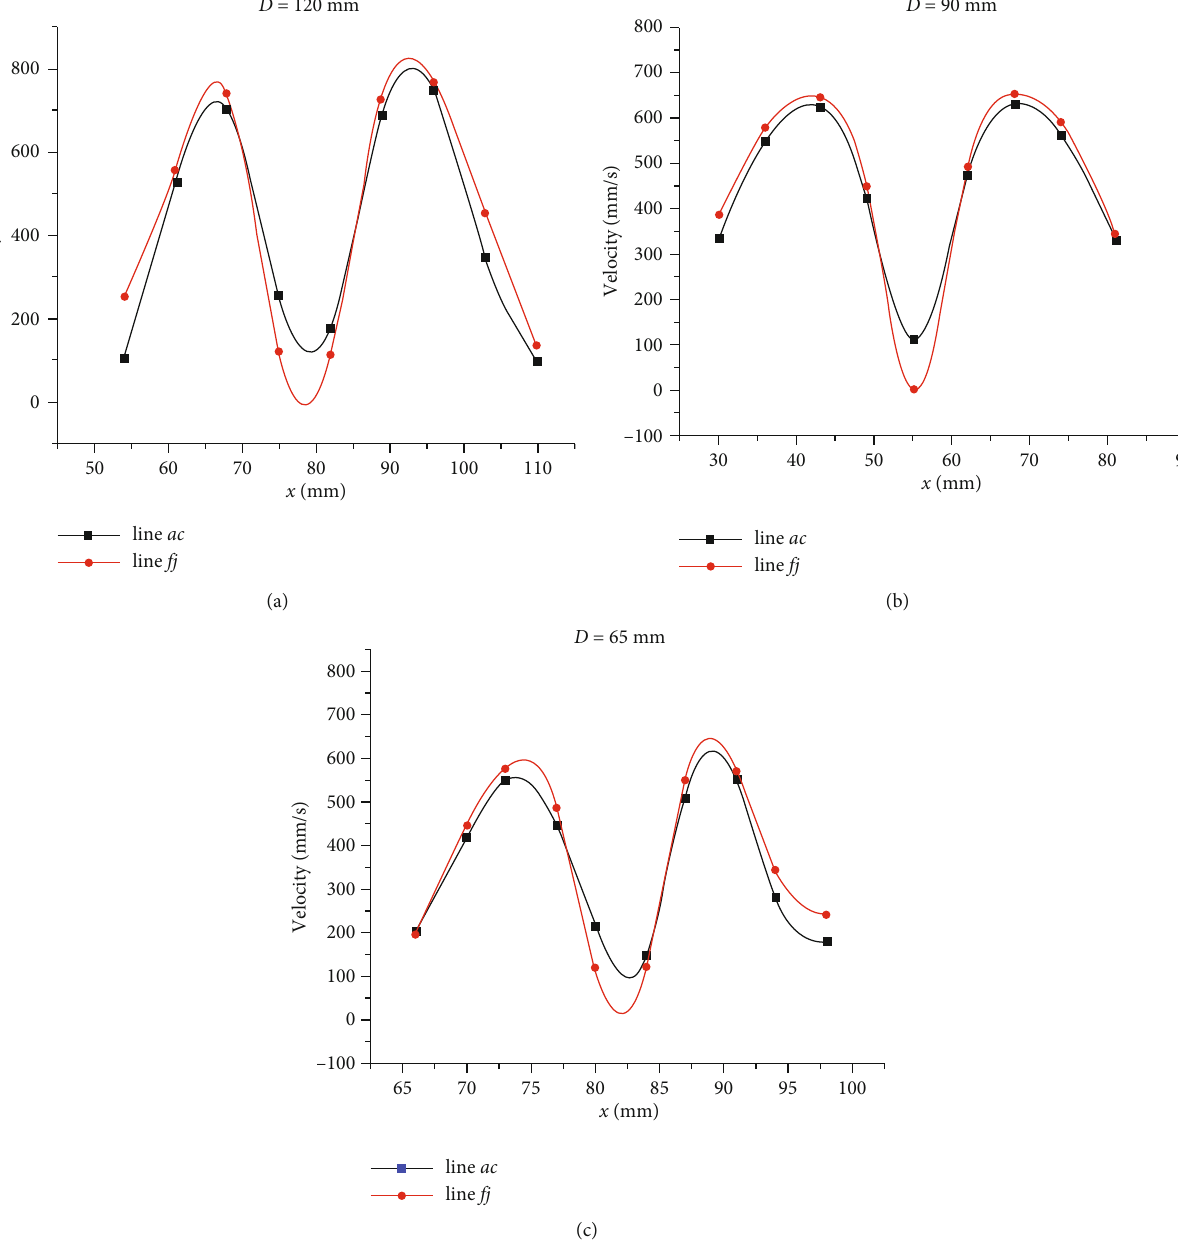
Figure 9: Velocity distribution of fl uid layer of other screw speci fi